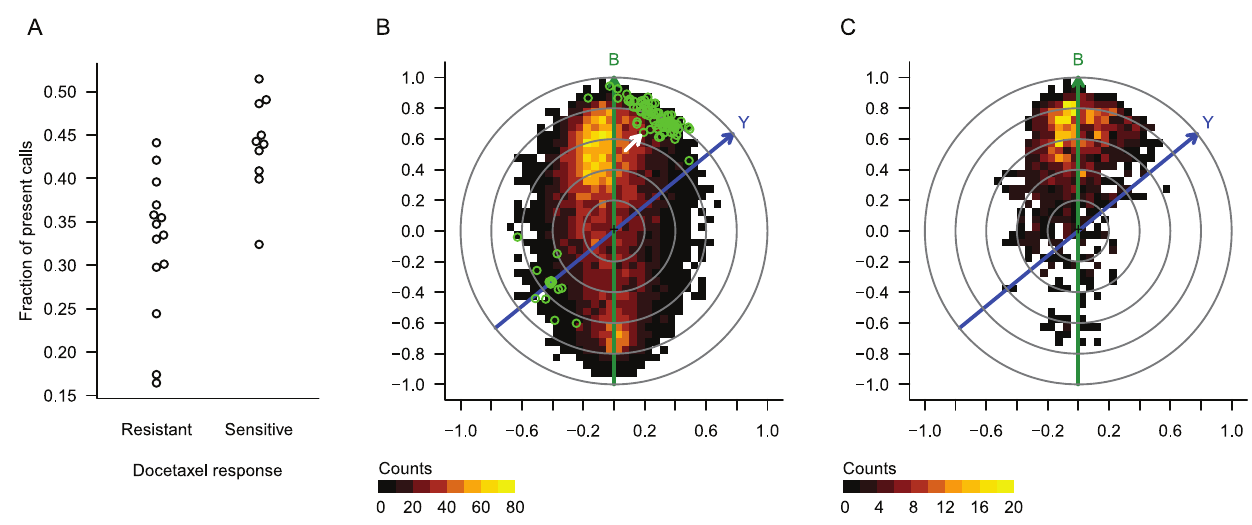
Figure 2. Case study 1: 26 breast tumors treated with neoadjuvant docetaxel. A) Tumor response is correlated with the fraction of present calls. B) Biasogram with a heatmap representing all 12,625 probe sets, and the 92 putatively discriminatory genes indicated in green. C) Biasogram displaying only the 1191 probe sets with variance above 2. In the biasograms, Y indicates the outcome vector (tumor response), B indicates the bias vector (fraction of present calls), the colorgram indicates a bivariate histogram of expression values, and the green circles indicate probe sets identified in the original study. The arrow indicates CYBA, the only gene that was validated in a second patient cohort.